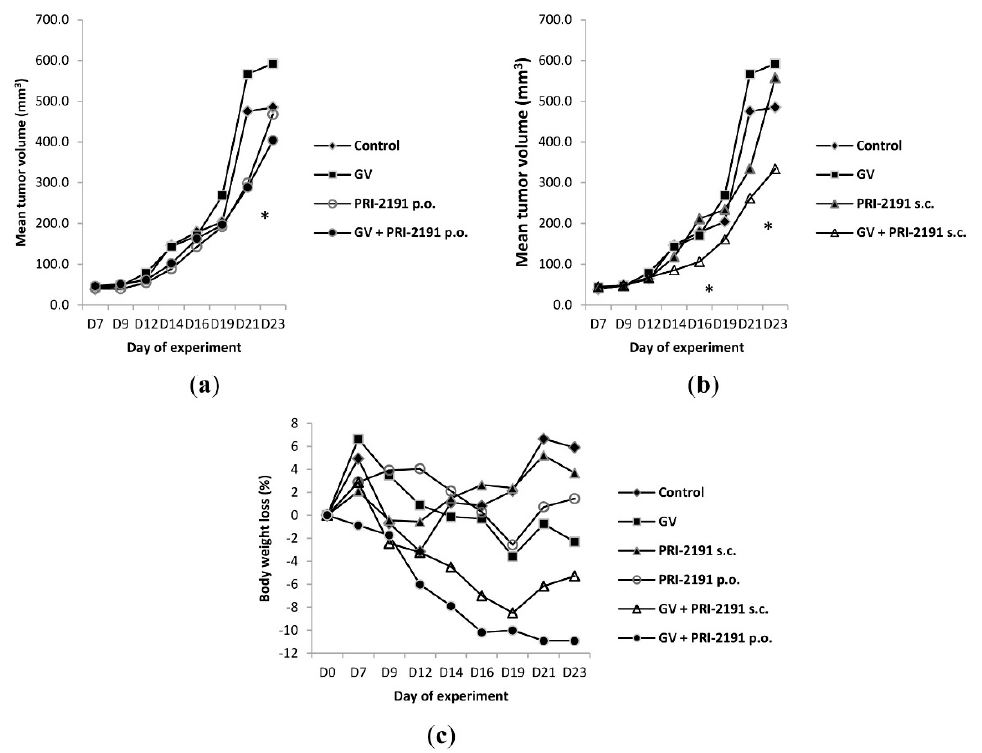
Figure 2. Kinetics of A549 tumor growth after ( a ) oral gavage or ( b ) s.c. administration of PRI-2191 analog alone or in combination with Gleevec (GV) and ( c ) body weight changes of treated mice. GV, imatinib; PRI-2191 and PRI-2205, vitamin D analogs; s.c. , subcutaneous; ( a ) * p < 0.05, Kruskal–Wallis ANOVA, GV + PRI-2191 when compared to imatinib (GV) on Day 21; ( b ) * p < 0.05, Kruskal–Wallis ANOVA, GV + PRI-2191 when compared to PRI-2191 on Day 16; GV + PRI-2191 when compared to imatinib (GV) on Day 21. Number of mice per group: control, eight; GV (imatinib), seven; and in each treatment group receiving analog PRI-2191: nine. Table 2. The effect of PRI-2191 alone or in combination with GV on tumor growth in mice bearing subcutaneous human lung cancer A549.